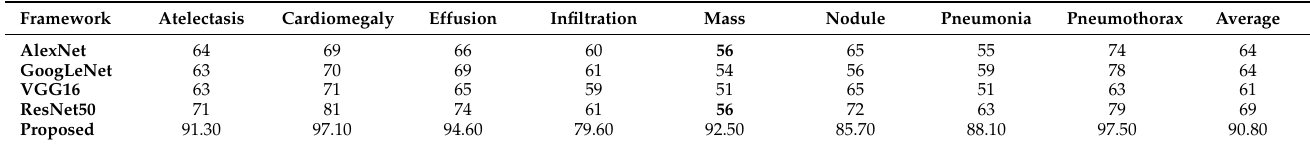
Table 3. Comparison of the presented work with base techniques for the AUC measure.